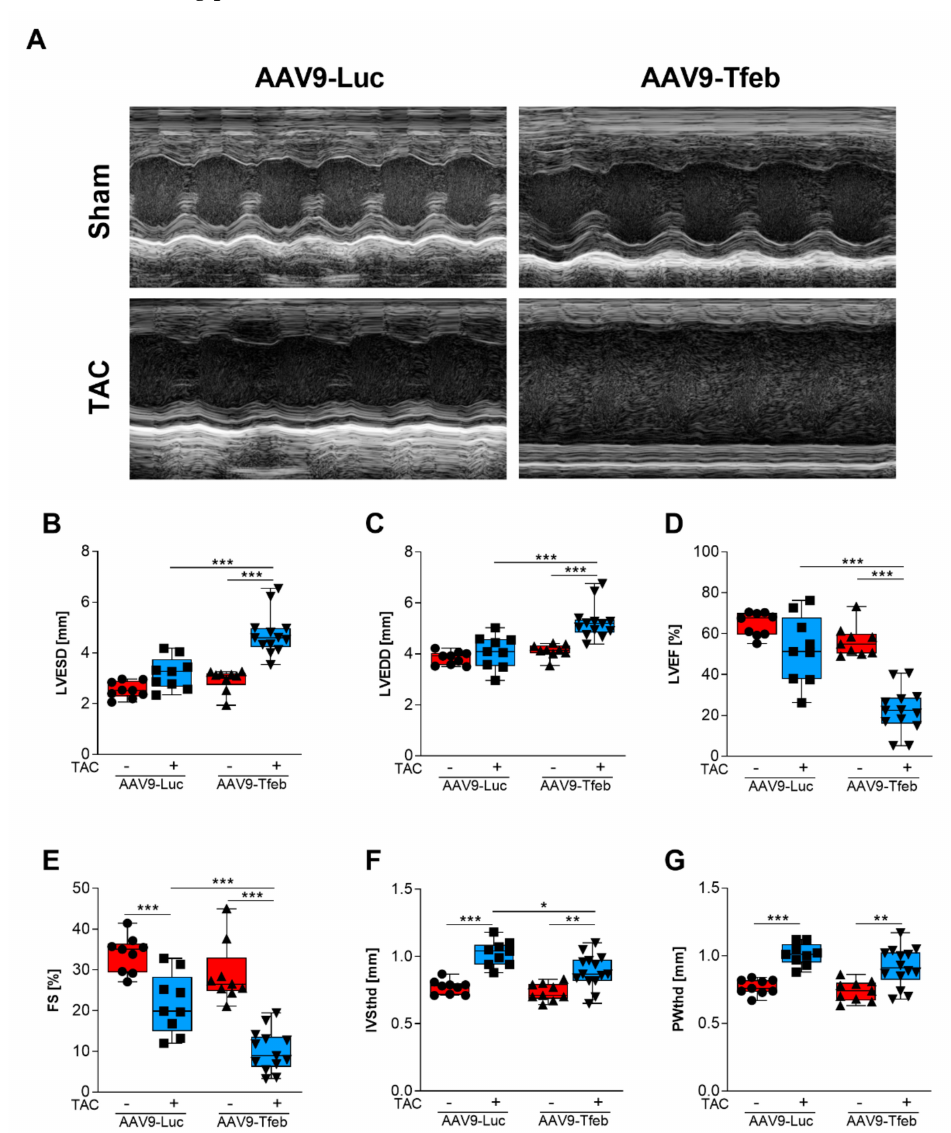
Figure 2. Cardiomyocyte-specific overexpression of TFEB leads to heart failure in response to 28 days of TAC. ( A ) Representative echocardiographic M-mode tracings of sham and TAC treated AAV9-Luc and AAV9-Tfeb mice. Echocardiographic assessment of left ventricular endsystolic (LVESD, ( B )) and enddiastolic diameter (LVEDD, ( C )), left ventricular ejection fraction (LVEF, ( D )), fractional shortening (FS, ( E )), thickness of the interventricular septum in diastole (IVSthd, ( F )) and posterior wall thickness in diastole (PWthd, ( G )) of sham and TAC treated AAV9-Luc and AAV9-Tfeb mice after 28 days. Boxes show IQR ± minimum to maximum values. * p < 0.05; ** p < 0.01; *** p <